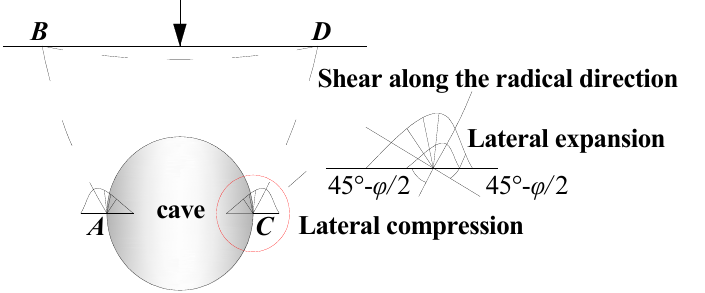
Figure 4. Vertical cross-section of limestone strata containing the spherical Karst cave, which was affected by the vertical load.